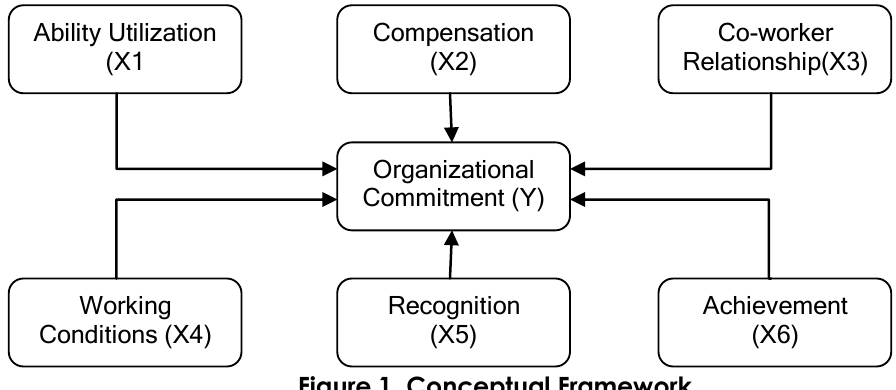
Figure 1. Conceptual